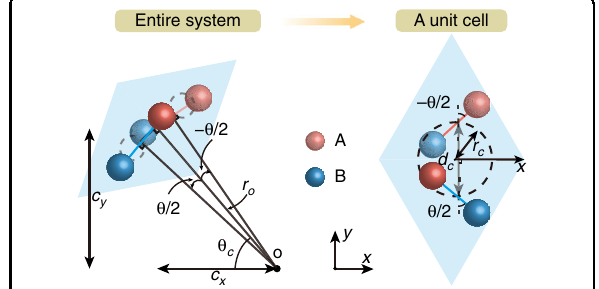
Fig. 3 Lattice dislocation mapping. Schematic of the lattice dislocation under speci fi c r o , θ , and θ c (left panel), which can be characterized in terms of θ c , r c , and d c (right